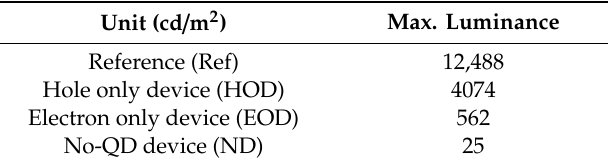
Table 2. The maximum luminance for four